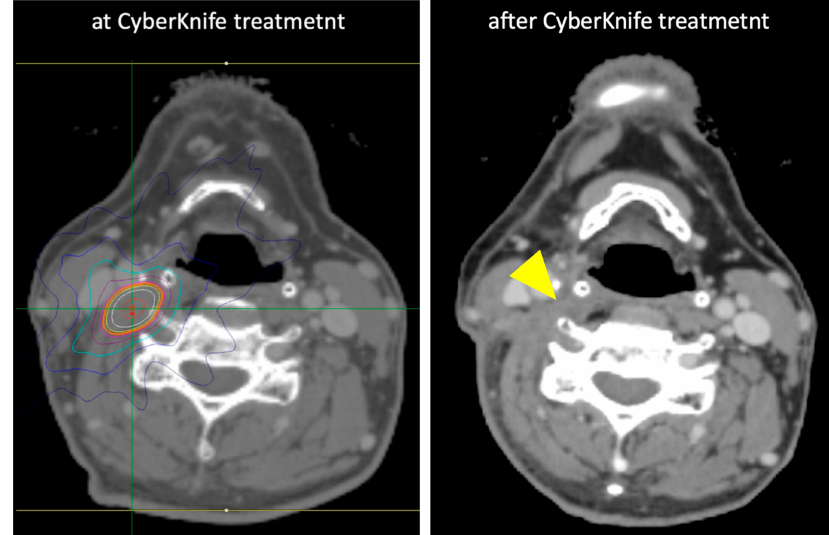
Figure 4. Treatment response after CyberKnife in a representative case. The case is as same as the